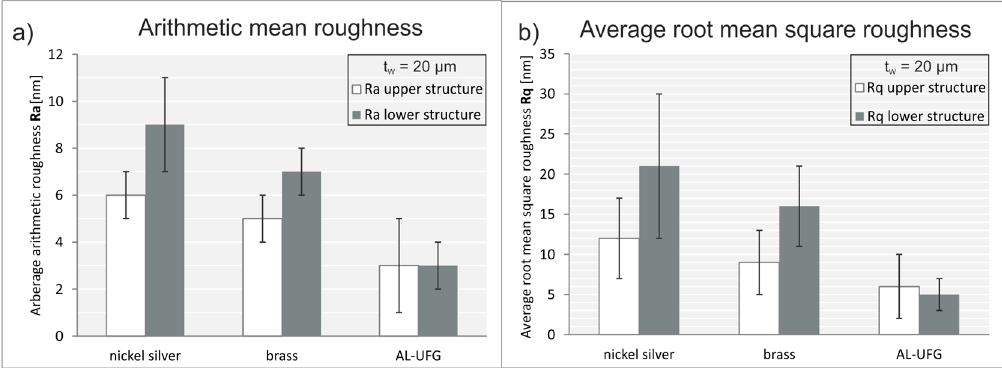
Figure 10. Material impact on the surface roughness: ( a ) arithmetic roughness and ( b ) root mean squared roughness.